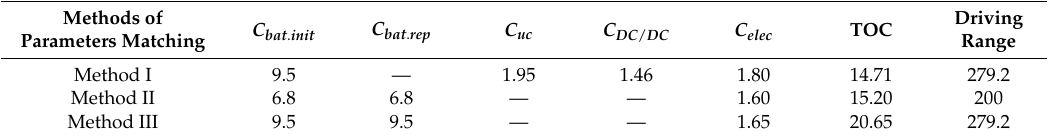
Table 3. Results comparison of three parameters matching